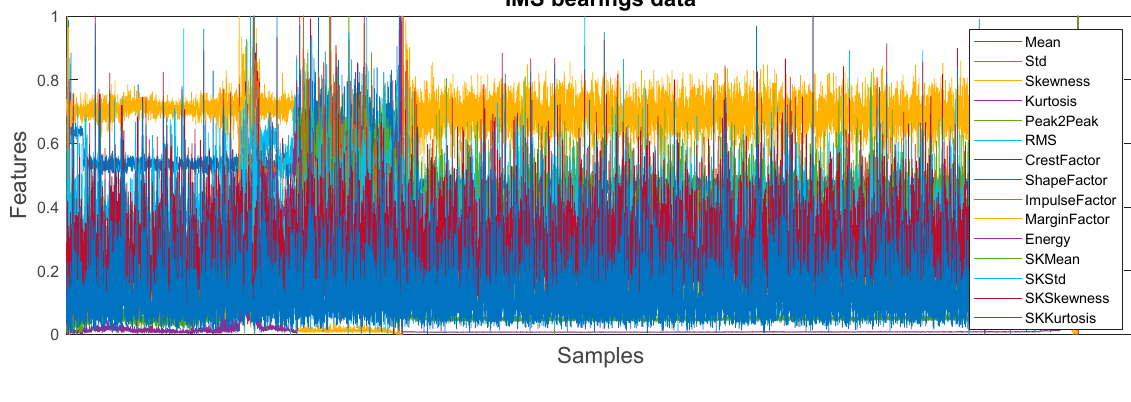
Figure 5. Adopted methodology during health assessment model development.